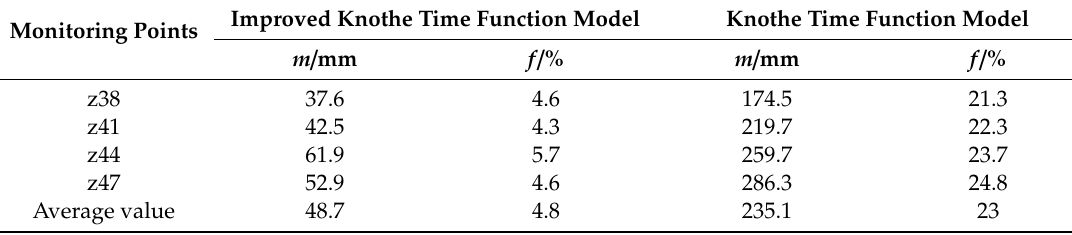
Table 3. Error between monitored and predicted Table 2. Time influence parameters of different main strike profile monitoring points. Monitoring Points Model Parameter